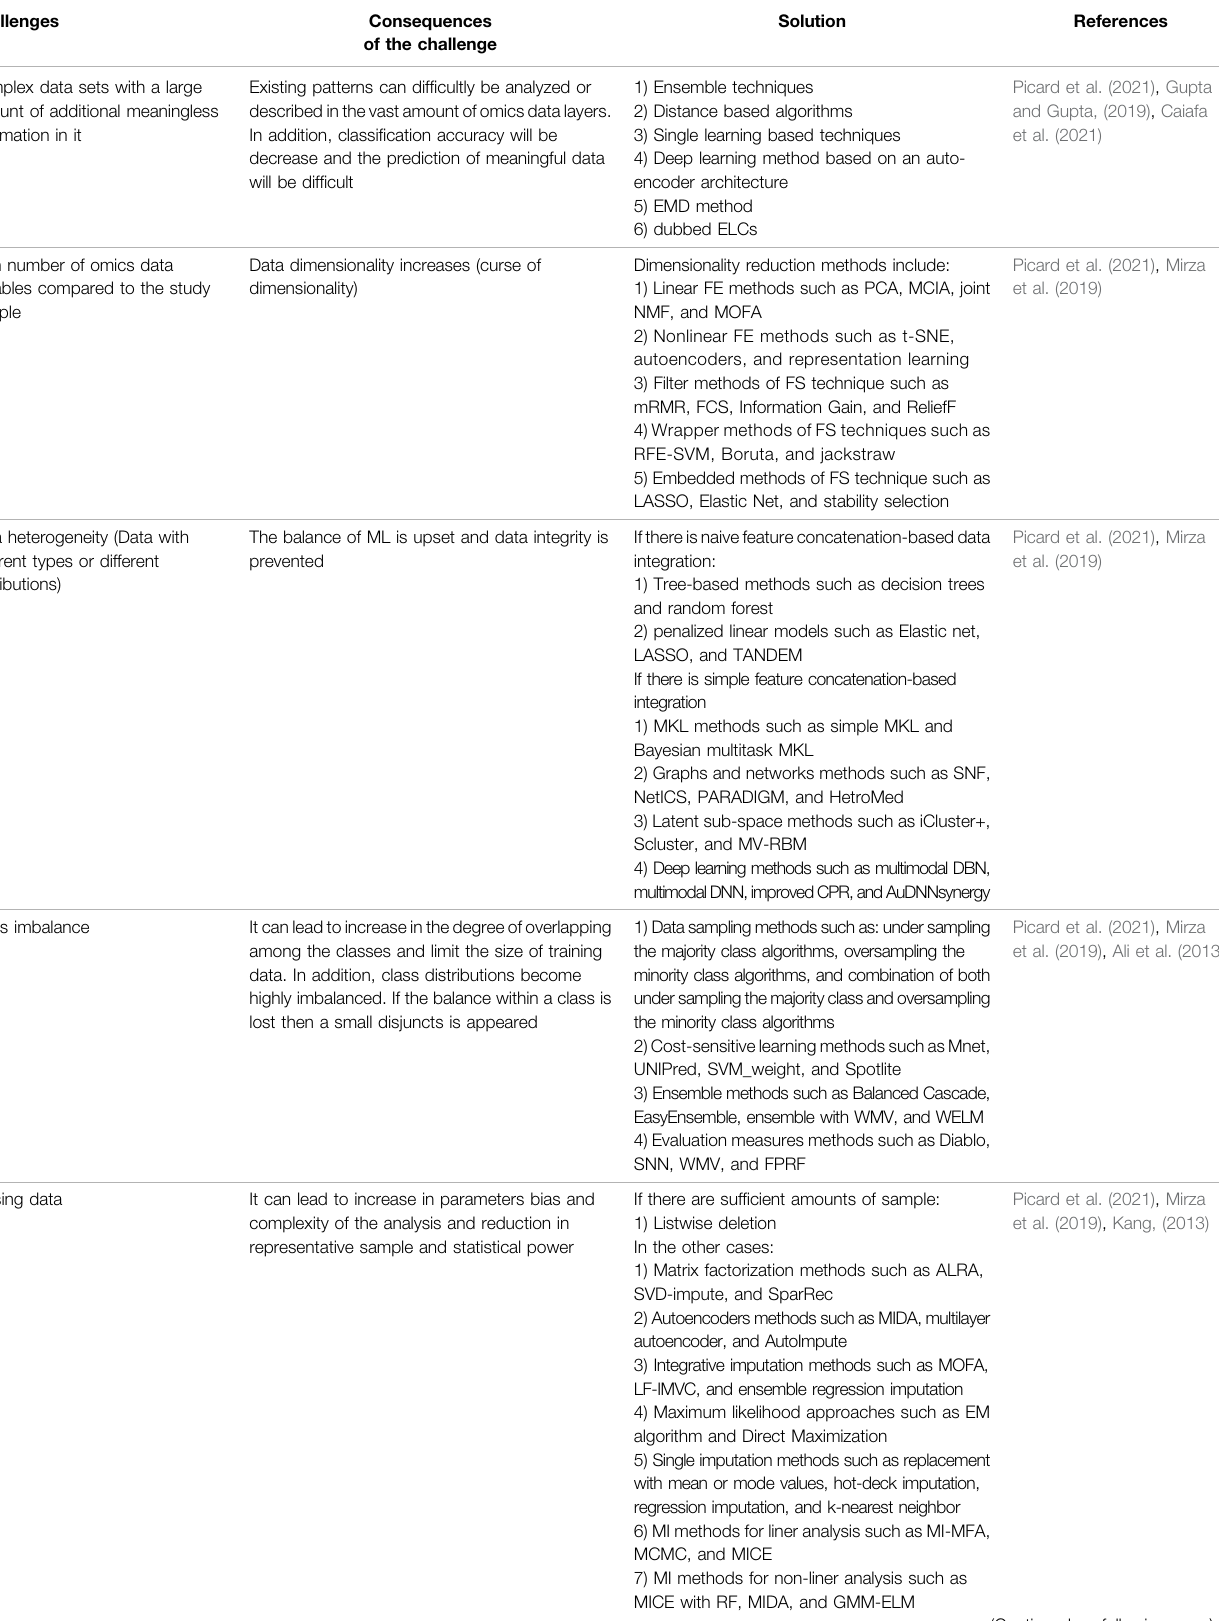
TABLE 1 | Challenges of multi-omics data analysis by ML and their